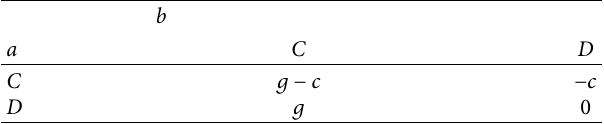
Table 1: Payoffs for two agents a and b engaged in a prisoner’s dilemma game, g > c >